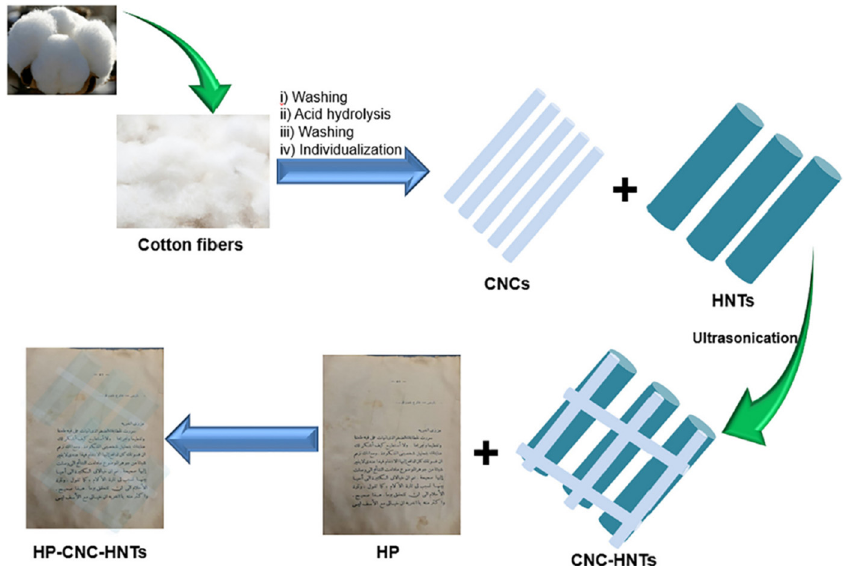
Figure 8. Schematic diagram representing the synthesis of CNC-HNTs conservation layer and their usage in consolidation to historical paper. Reproduced with permission [59]. Copyright 2022, Elsevier.